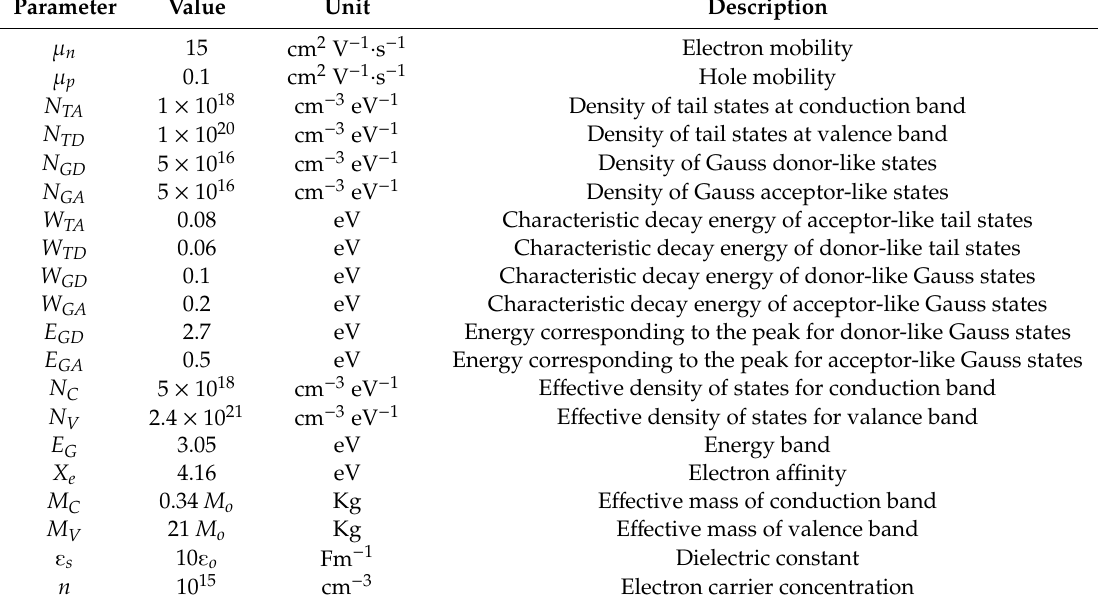
Table 1. Simulation parameters for the a-indium-gallium-zinc (IGZO) thin-film transistors (TFTs). Parameter Value Unit Description µ 2 V − 1 · s − 1 Electron mobility n 15 cm µ 2 V − 1 · s − 1 Hole mobility p 0.1 cm N TA 1 × 10 18 cm − 3 eV − 1 Density of tail states at conduction